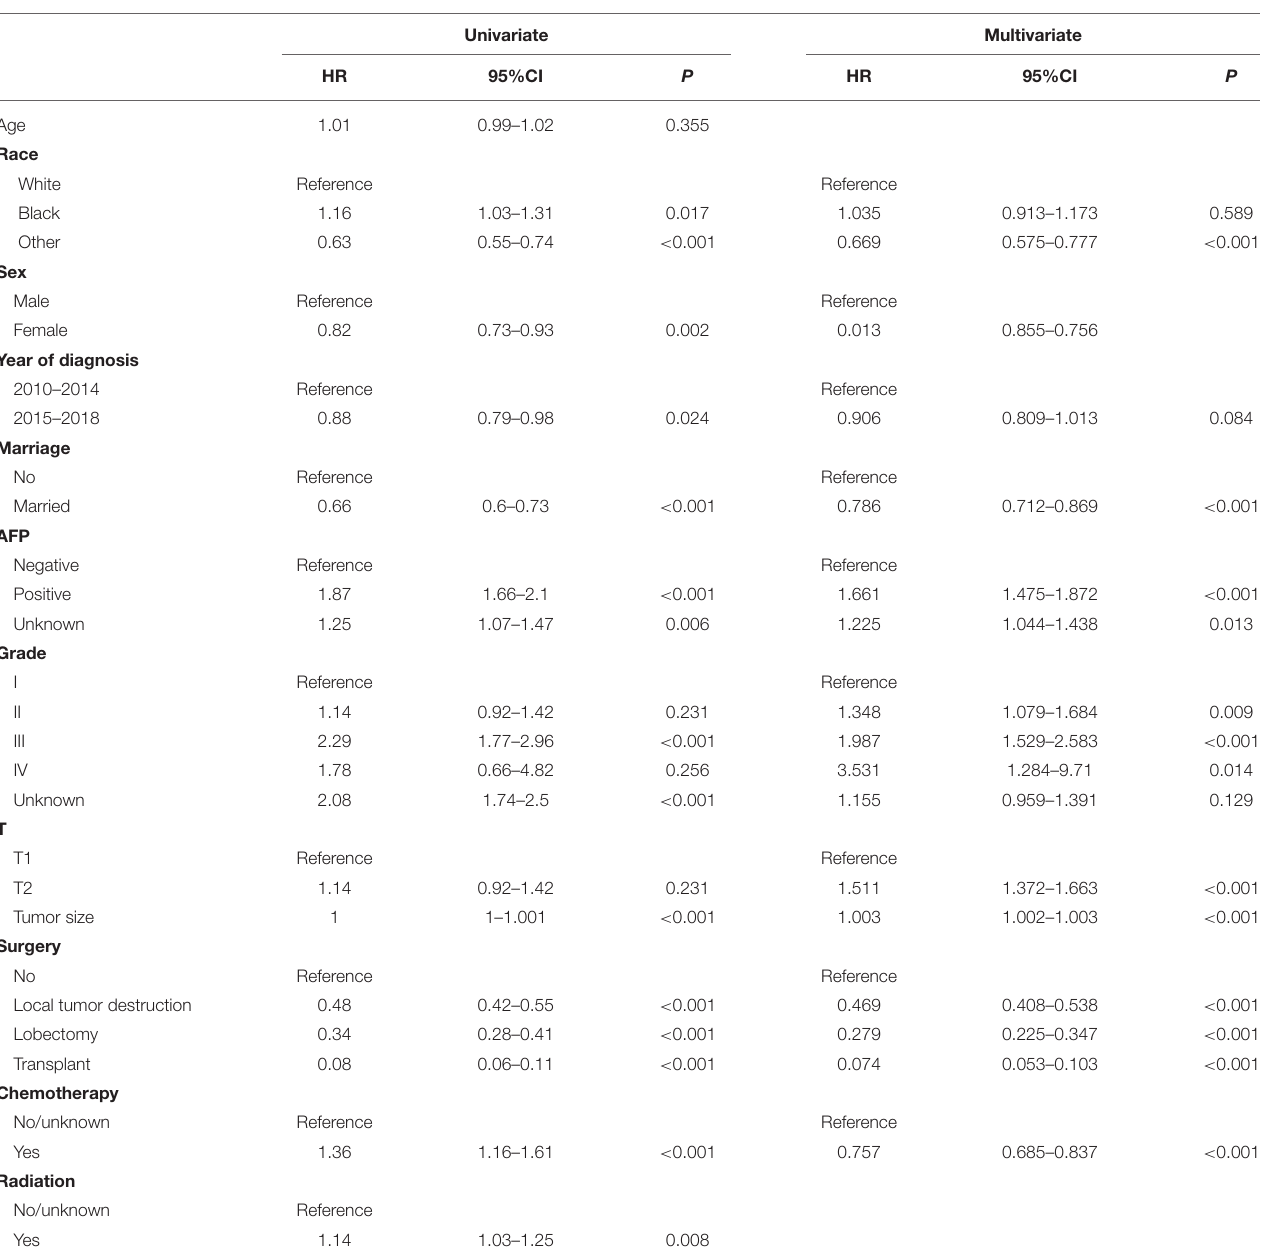
TABLE 2 | Univariate and multivariate analyses of CSS in training cohort. Univariate